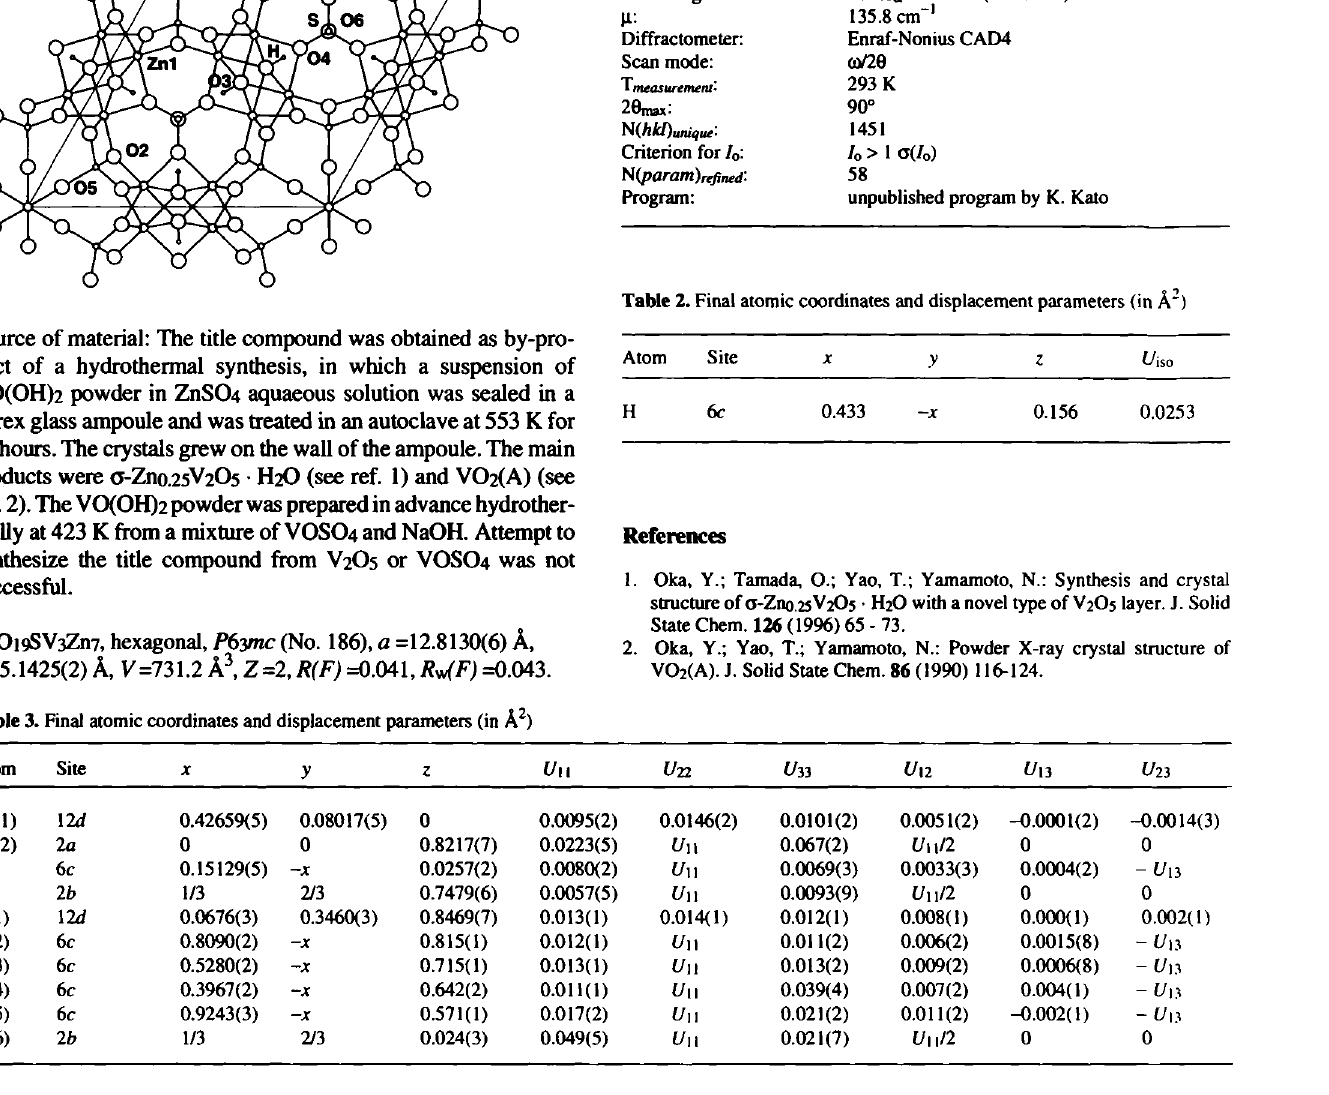
Table 1. Parameters used for the X-ray data collection Crystal: